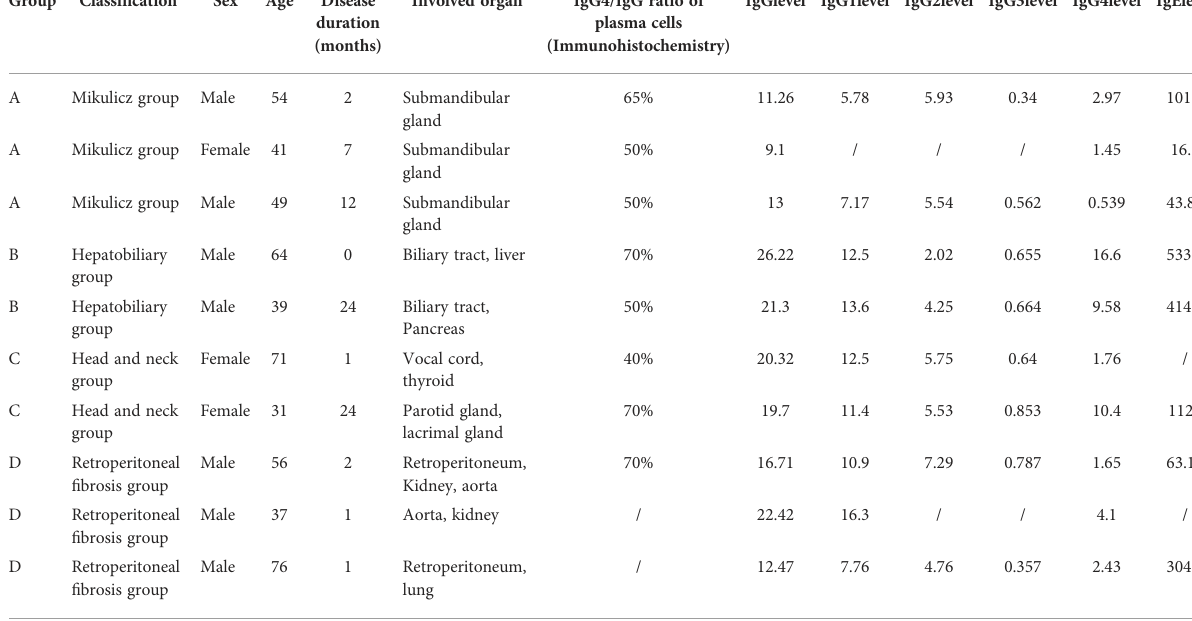
TABLE 1 Main clinical characteristics of IgG4-RD patients in this